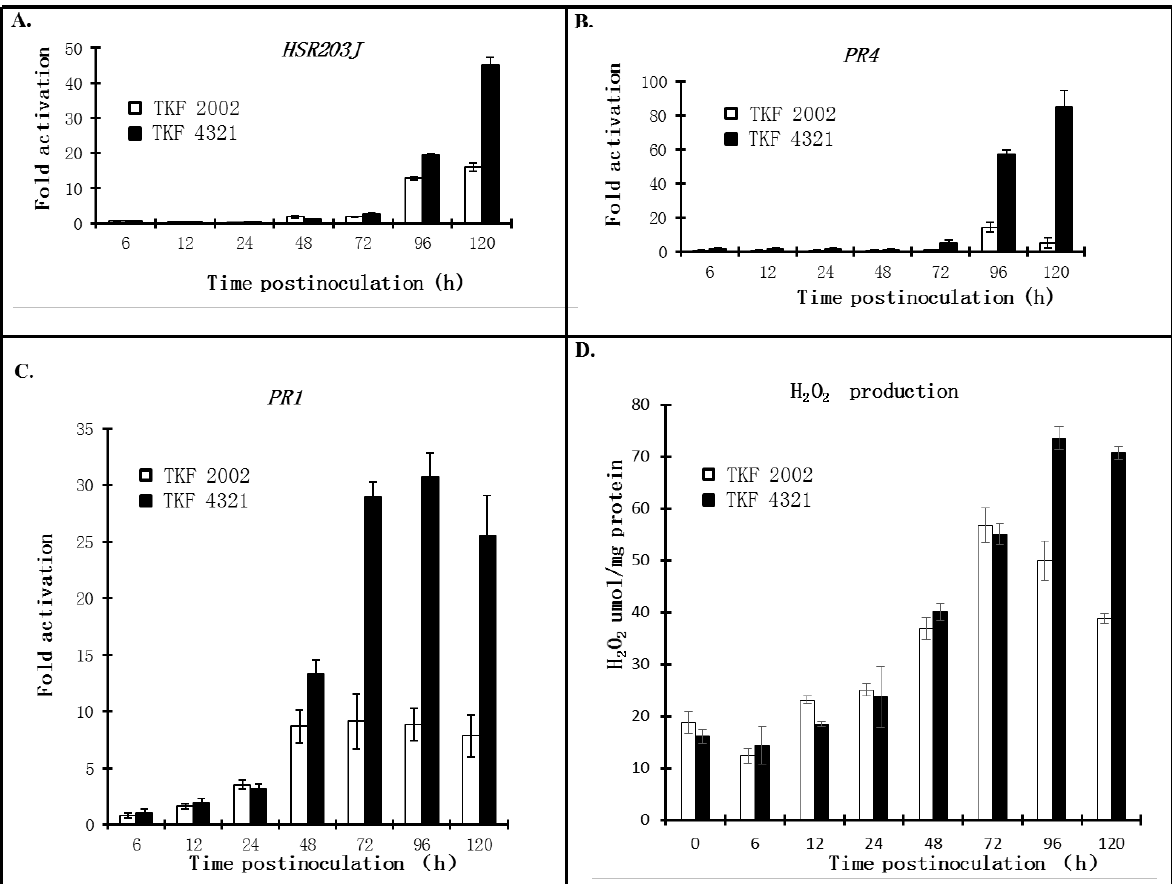
Figure 3. Real-time PCR analysis of host responses and H 2 O 2 production during blue mold infection of tobacco. Expression profiles for HSR203J , PR1 , and PR4 were determined at seven time points between six and 120 hpi ( A – C ). Quantification of endogenous H 2 O 2 in tobacco leaves is shown in